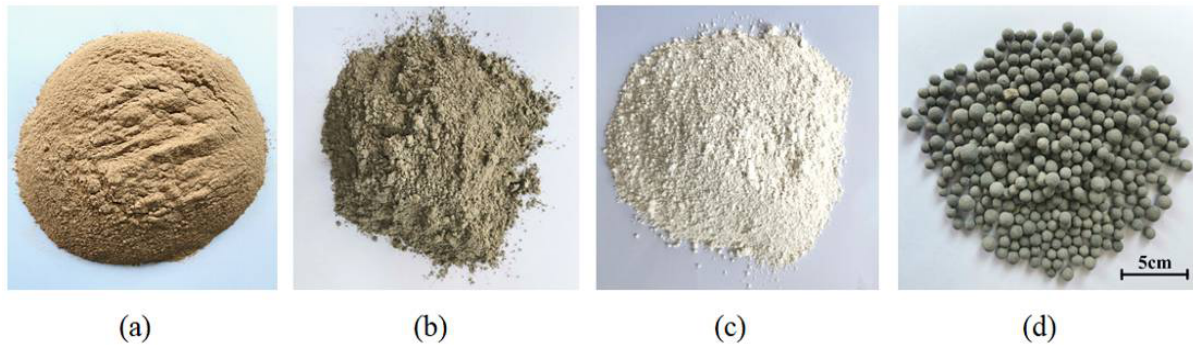
Figure 1. The raw materials: rock power ( a ), cement ( b ), lime ( c ) and FAC ( d ).